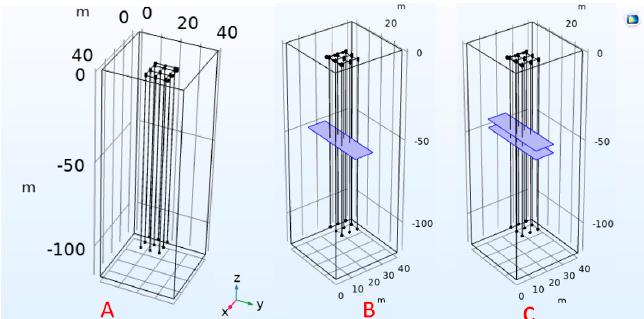
Figure 6. Simulated rock mass with U pipes and model specifications. ( A ) rock mass without a frac- ture (NF). ( B ) rock mass with a single horizontal fracture (F1). ( C ) rock mass with two horizontal fractures (F2).